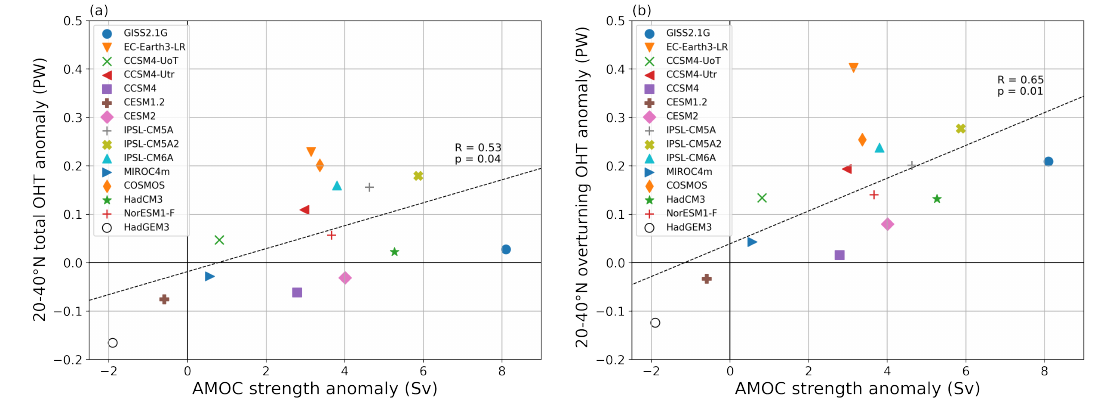
Figure 11. (a) The mPWP–PI change in average total Atlantic OHT between 20–40 ◦ N and change in AMOC strength. (b) The mPWP–PI change in overturning Atlantic OHT between 20–40 ◦ N and change in AMOC strength. The dotted line indicates a linear fit by least squares with the correlation coefficient R and p value of fit shown. Table 2. Results of least squares linear fit between the mPWP–PI OHT anomaly and the AMOC strength anomaly. The latitude range indicates the latitudes over which the OHT has been averaged. OHT component Latitude range Slope Intercept R ( R 2 ) p value (PW/Sv) (PW) All models Total 20–40 ◦ N 0.024 − 0.019 0.53 (0.28) 0.044 Overturning 20–40 ◦ N 0.034 0.039 0.65 (0.42) 0.009 Total 30 ◦ S-60 ◦ N 0.018 − 0.014 0.50 (0.25) 0.056 Overturning 30 ◦ S–60 ◦ N 0.021 0.006 0.58 (0.34) 0.025 All models excluding Total 20–40 ◦ N 0.024 − 0.031 0.58 (0.34) 0.031 EC-Earth3-LR Overturning 20–40 ◦ N 0.034 0.021 0.77 (0.59) 0.001 Total 30 ◦ S–60 ◦ N 0.018 − 0.023 0.54 (0.29) 0.045 Overturning 30 ◦ S–60 ◦ N 0.020